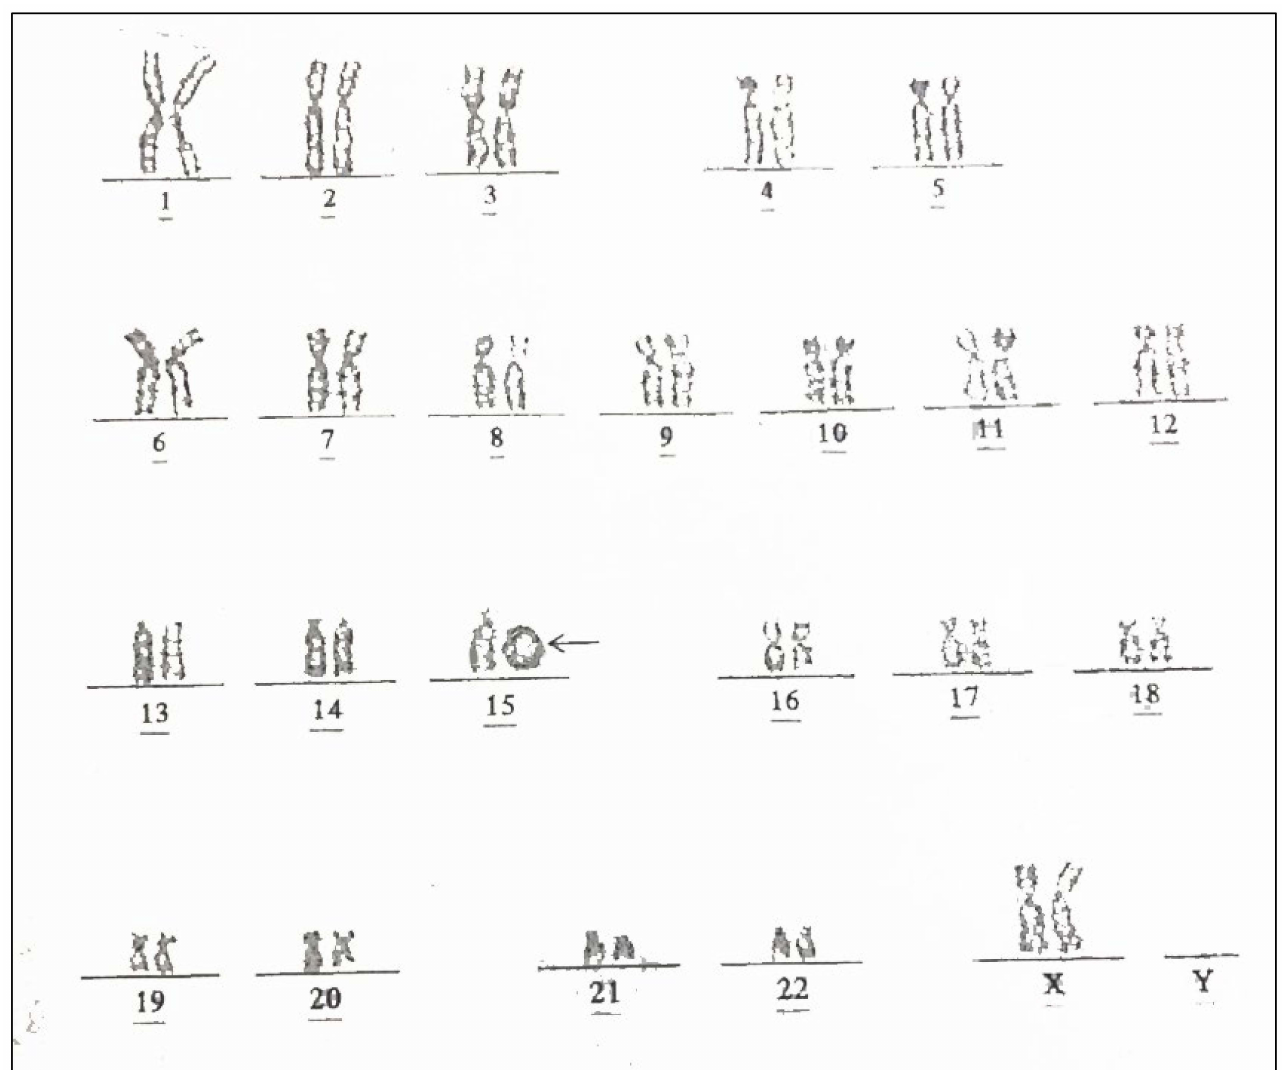
Figure 2. Karyotype of the fetus from the present study shows a ring chromosome 15; 46,XX, r(15)